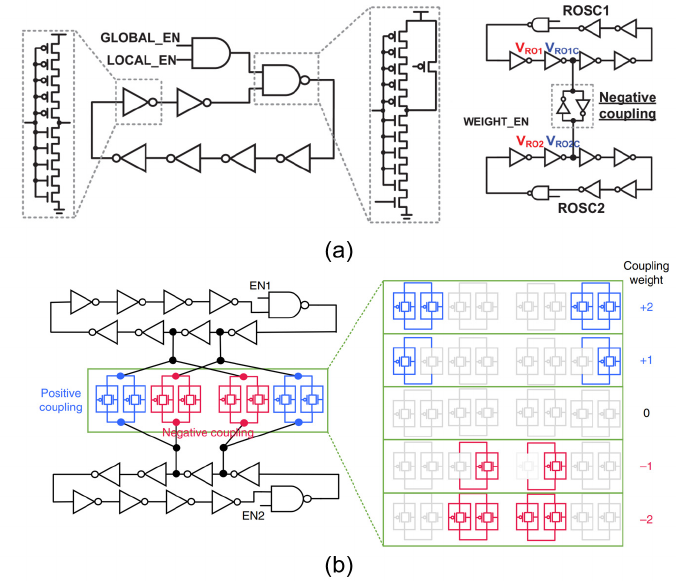
Figure 12. ( a ) Ring oscillator network coupled through inverters [3]; ( b ) same-node and cross-node coupling configuration for positive and negative coupling, transmission gates controlled five coupling strengths [44].